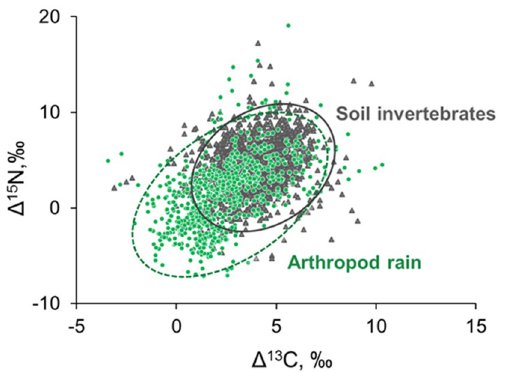
Figure 1. Litter-normalized isotopic composition (Δ 13 C and Δ 15 N values) of the arthropod rain (green dots and dashed line, original data, each point is one animal or several conspecifics, n = 730) and soil invertebrates (gray triangles and solid line, published data, points represent the mean value of species in different ecosystems, n = 1300). Standard ellipses show the 95% confidence interval.